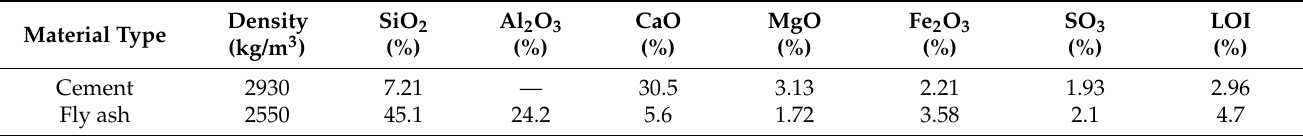
Table 1. Performance and technical indexes of main raw materials.